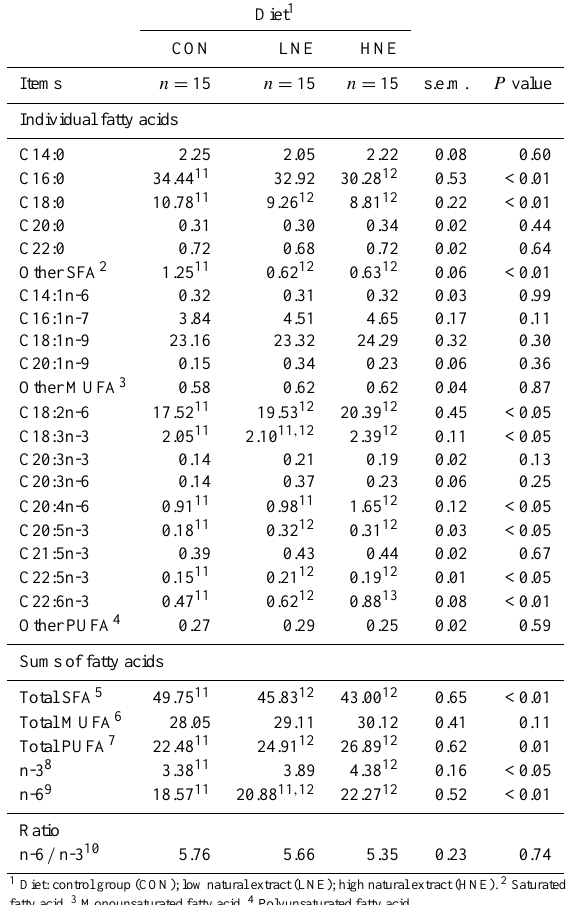
Table 5. Effect of Lippia citriodora extract on fatty acid composi- tion (% of total fatty acids) of meat in New Zealand white rabbits. Diet 1 CON LNE